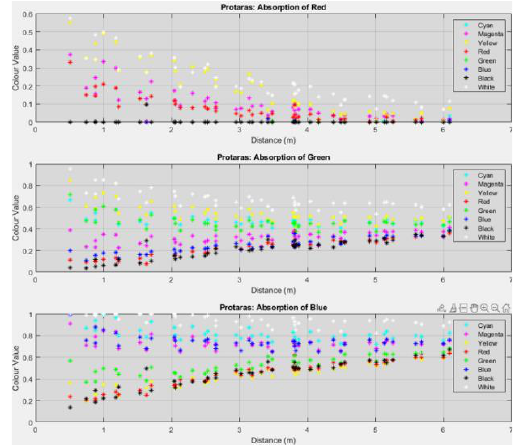
Figure 2. The diagram shows the value of the intensity absorption of Red, Green and Blue colour channels (top to bottom), for each of the eight main colour patches (Red, Green, Blue, Cyan, Magenta, Yellow, Black, White), based on camera to object distances for Protaras test site.